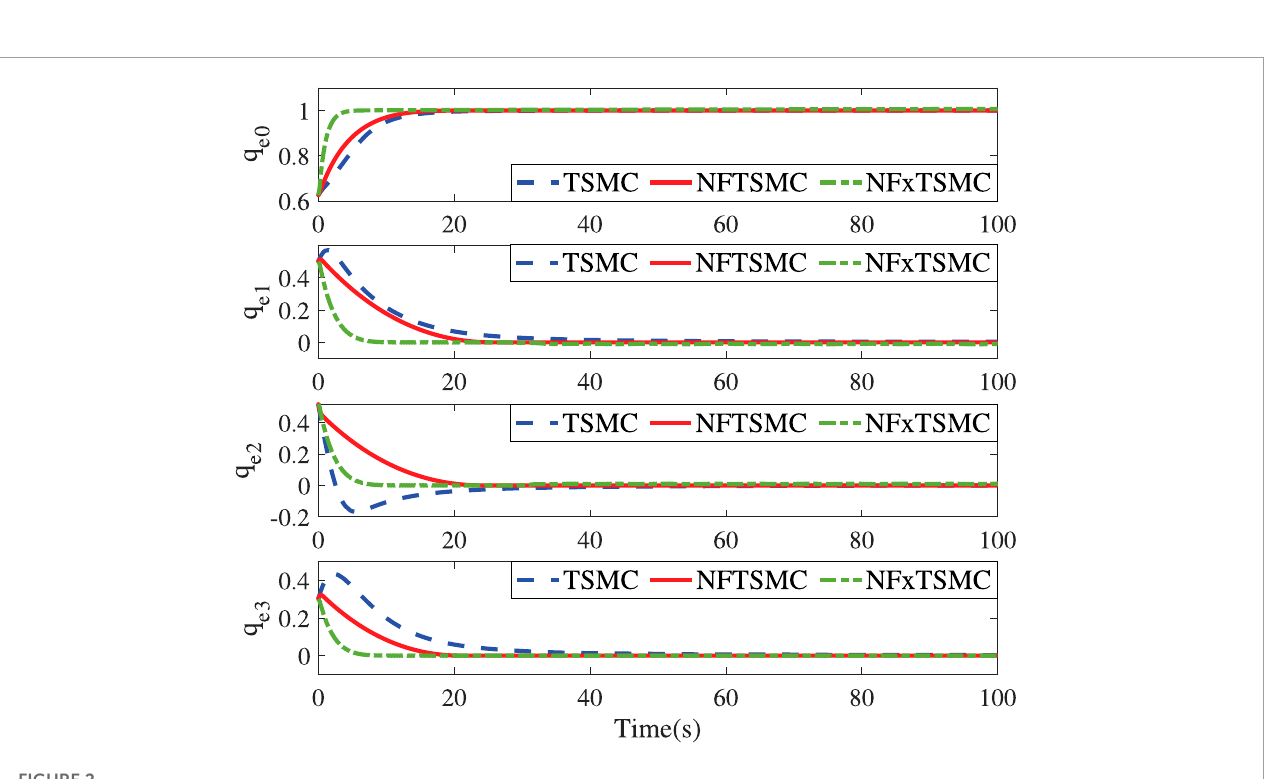
FIGURE 2 Time responses of q e for different